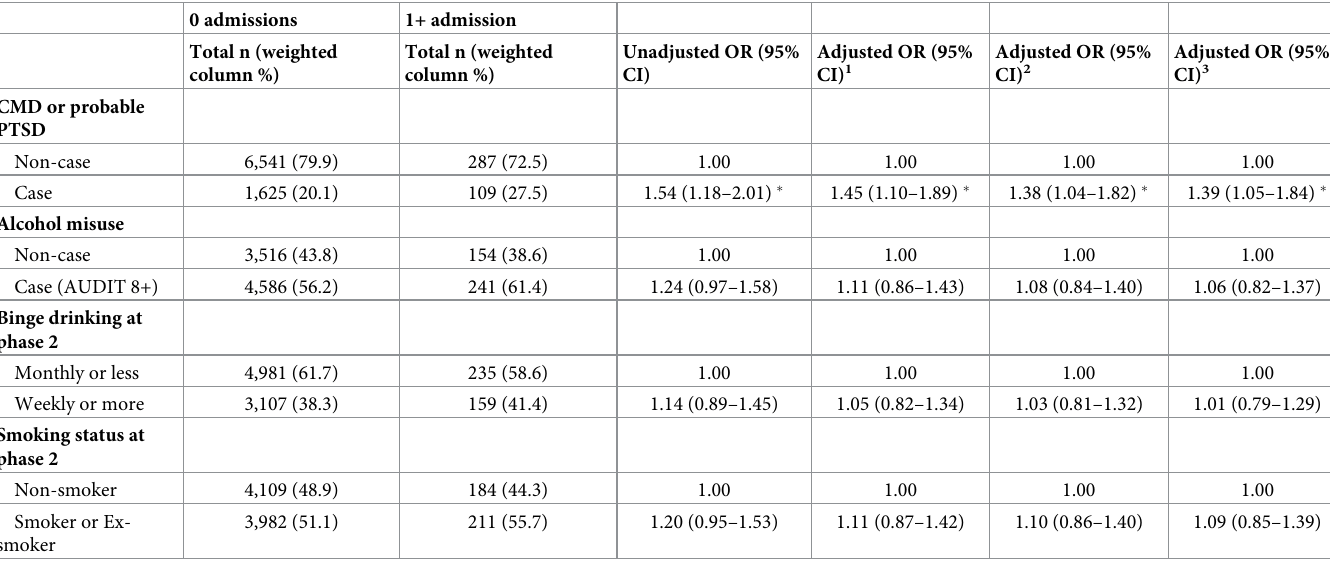
Table 3. Risk factors at phase 2 associated with having an admission to hospital for an accident or